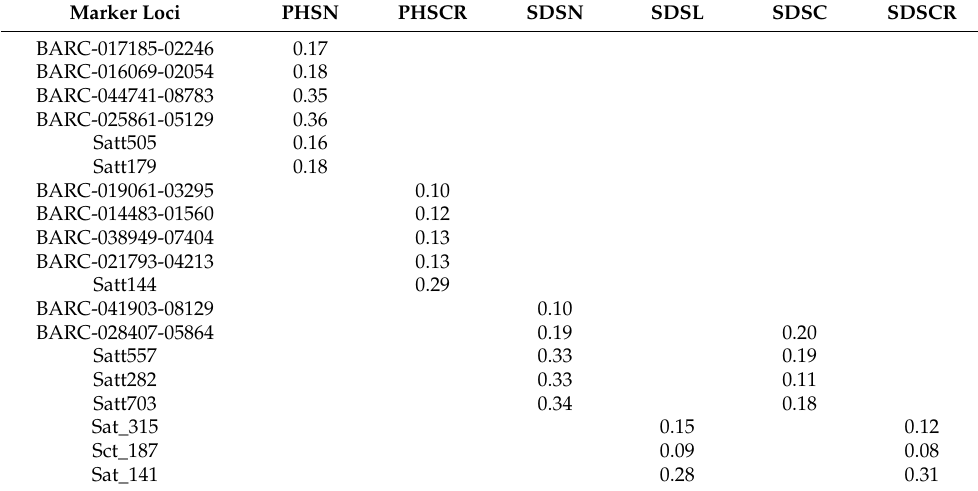
Table 3. Marker loci associated with traits of soybean plant height, stem diameter, and their variation under low-light conditions, along with the explanation rates of different phenotypes.